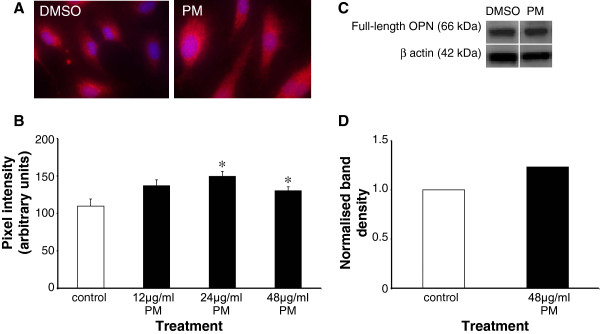
 Localisation and expression of osteopontin following PM exposure.A, exemplar images from immunostaining studies showing the induction of osteopontin expression upon PM treatment. B, results of pixel intensity analysis of images such as those shown in A. Data are mean ± S.D. pixel intensities from 10 cells at each concentration. *p < 0.05 compared to controls. C, Western blot analysis showed the presence of osteopontin at 66 kDa, which was greater in cells treated with 48 μg/ml PM for 24 h. D, quantification of band densities showed a 25% increase in osteopontin levels following PM exposure.